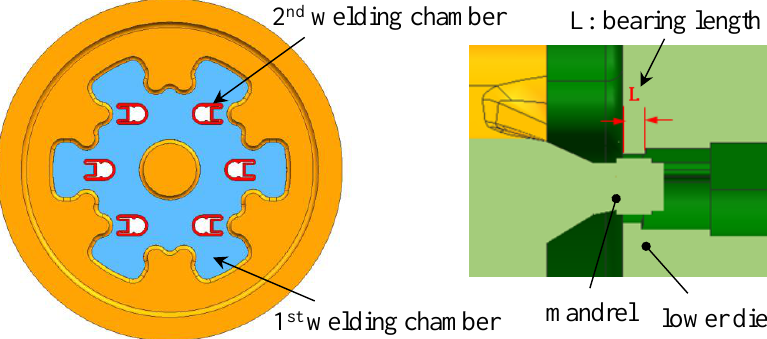
Figure 3. The main structures of lower die.